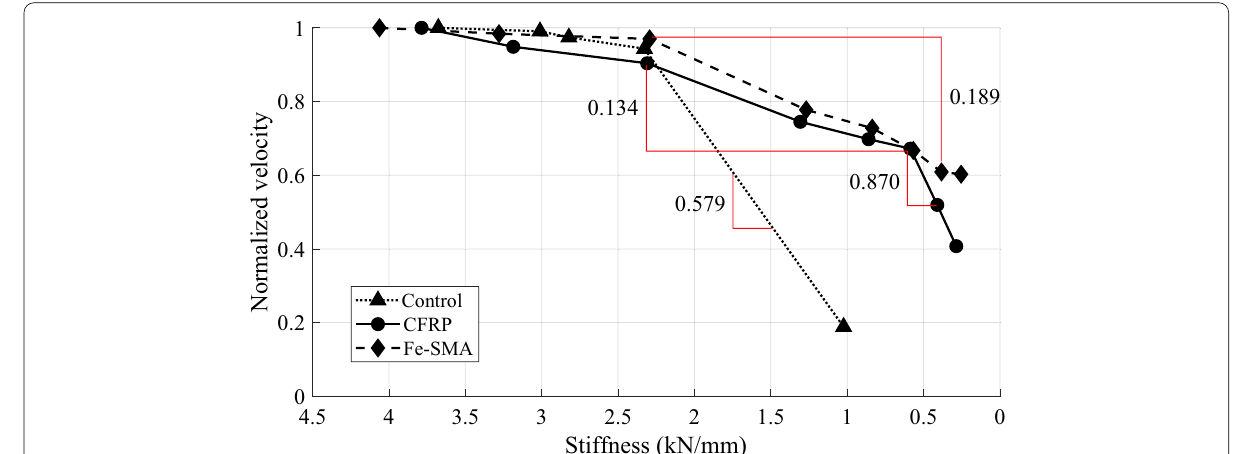
Fig. 16 Relationship between normalized through-thickness wave velocity and secant